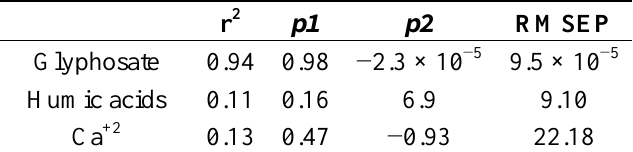
Table 3. The adjusting parameters (r 2 , p1, p2 and RMSEP) from the PLS prediction models for the data from the validation set.